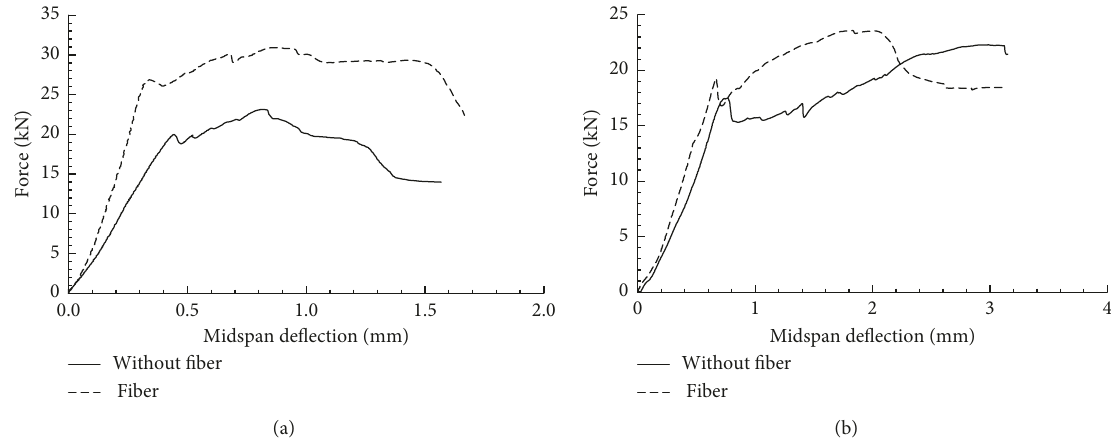
Figure 7: Effect of fiber mesh on composite beam behavior. (a) Fully bonded. (b)